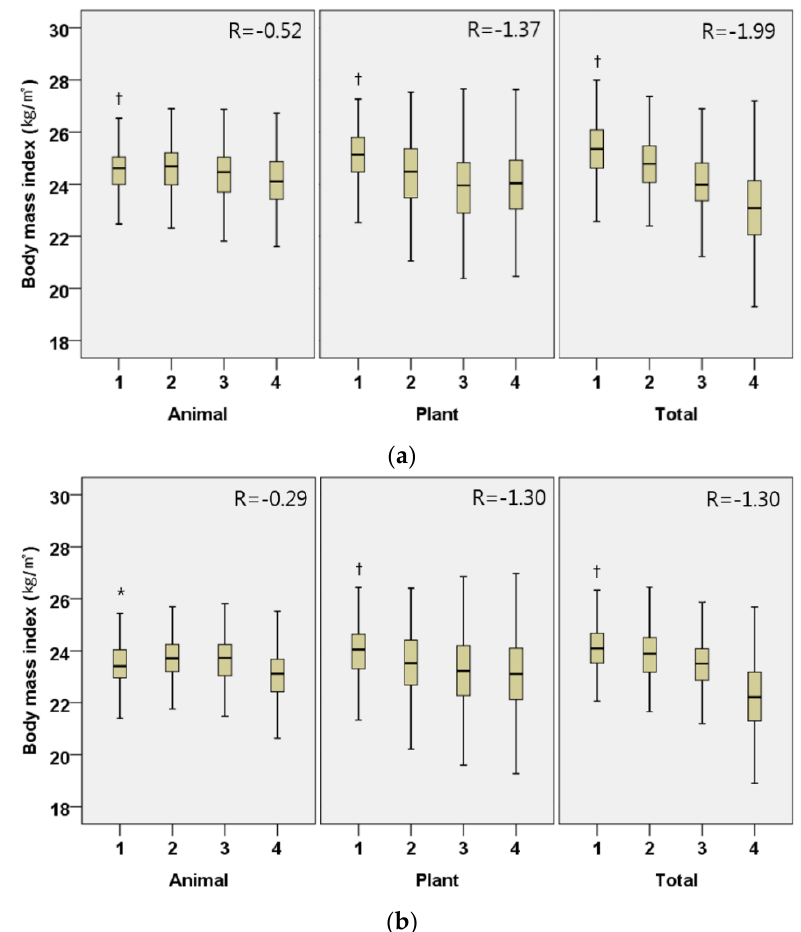
Figure 1. Adjusted body mass index (kg/m 2 ) by the quartiles of daily animal, plant, and total protein intake per weight (g/kg/day) in Korean elderly population. ( a ) Male; ( b ) Female. All models are adjusted for age (year), household income quartile, education ( ≤ 9 years, 10–12 years, 13 ≤ years), presence of chronic disease (yes or no), current smoking status (yes or no), alcohol intake frequency per week (0, 1, 2 ≤) , physical activity (MET/week), % energy from fat (%), % energy from carbohydrate (%) and total energy intake (kcal). Participants were divided into quartiles for daily animal, plant, and total protein intake per weight (g/kg/day); male animal (Q1 < 0.13, Q2 0.13 – 0.29, Q3 0.30 – 0.56, Q4 0.56<), male plant (Q1 < 0.45, Q2 0.45 – 0.61, Q3 0.62 – 0.79, Q4 0.79<), male total (Q1 < 0.70, Q2 0.70 – 0.97, Q3 0.98 – 1.30, Q4 1.30<), female animal (Q1 < 0.07, Q2 0.07 – 0.21, Q3 0.21 – 0.40, Q4 0.40<), female plant (Q1 < 0.42, Q2 0.42 – 0.57, Q3 0.58 – 0.74, Q4 0.74<), female total (Q1 < 0.59, Q2 0.59 – 0.82, Q3 0.83 – 1.14, (−1.55, −1.06), m ale total −1.30 (−1.58, −1.02), f emale animal −0.52 (−0.75, −0.30), f emale plant −1.37 (−1.60, −1.14), f emale total −1.99 (−2.29, −1.70) ; * p < 0.05, † p < 0.001 by trend test.